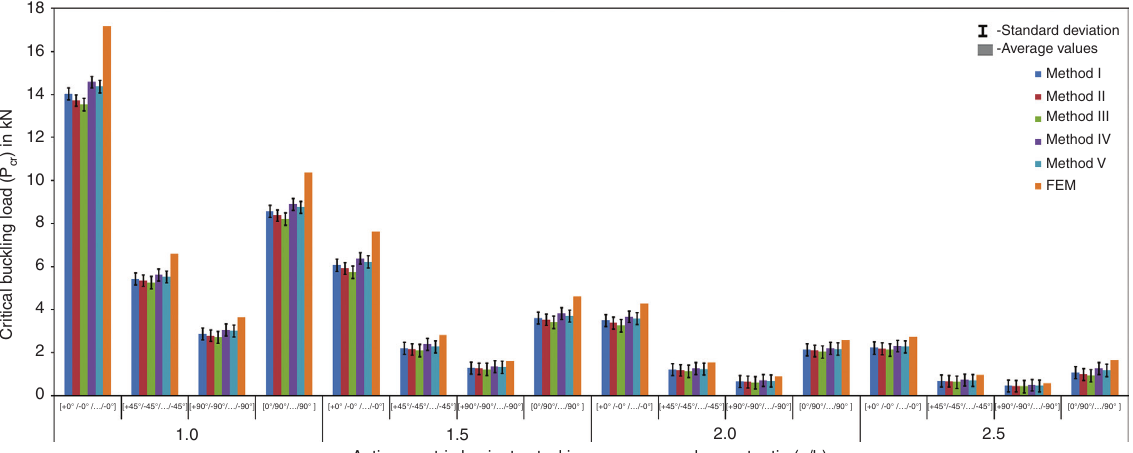
Figure 10 Critical buckling load for laminated skew plate ( α = 45 °